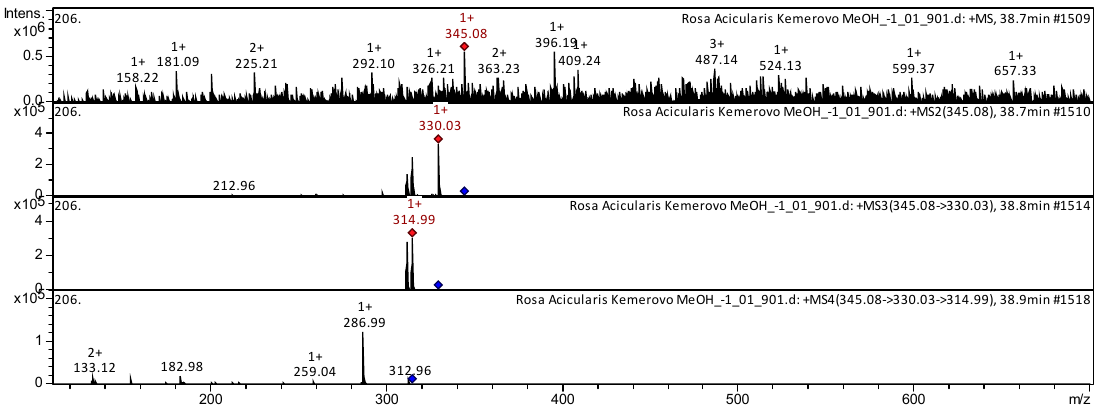
5 of 29 Figure 4. CID-spectrum of Tricin from extracts of R. davurica , m / z 329.19. The [M – H] – ion produced three fragment ions at m / z 313, m / z 259, and m / z 229 (Fig- ure 4). The fragment ion with m / z 313 produced two daughter ions at m / z 298 and m / z 271. The fragment ion with m / z 298 yielded two daughter ions at m / z 271 and m / z 227. It was